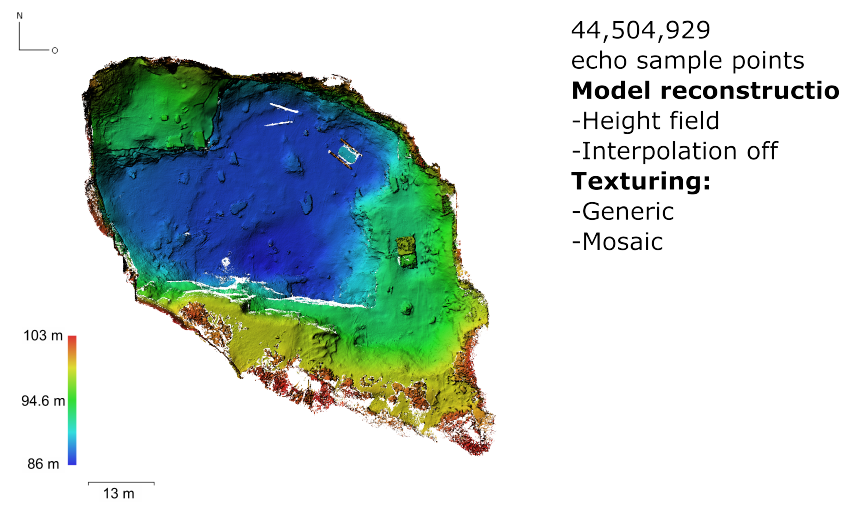
Figure 7. 3D Model of the sonar point cloud with the reconstruction parameter for Agisoft Metashape.